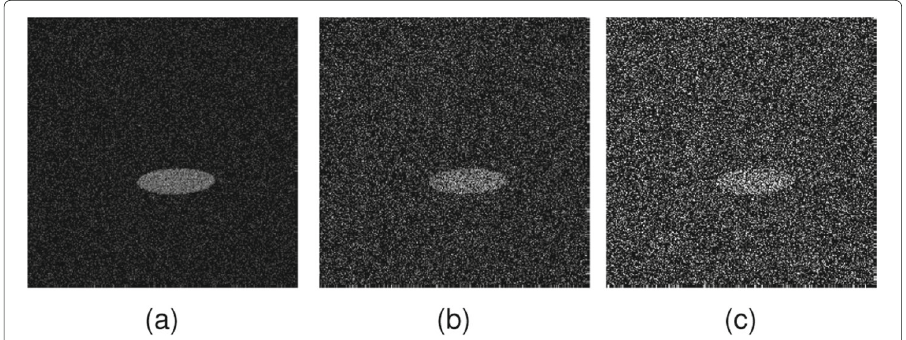
Fig. 3 Synthetic image sequences degraded with additive noise with the variance ( a ) σ 2 n = 2%, ( b ) σ 2 n = 6%, and ( c ) σ 2 n = 10%. The parameters λ 1 = λ 3 = 1, λ 2 = 0 for all three image